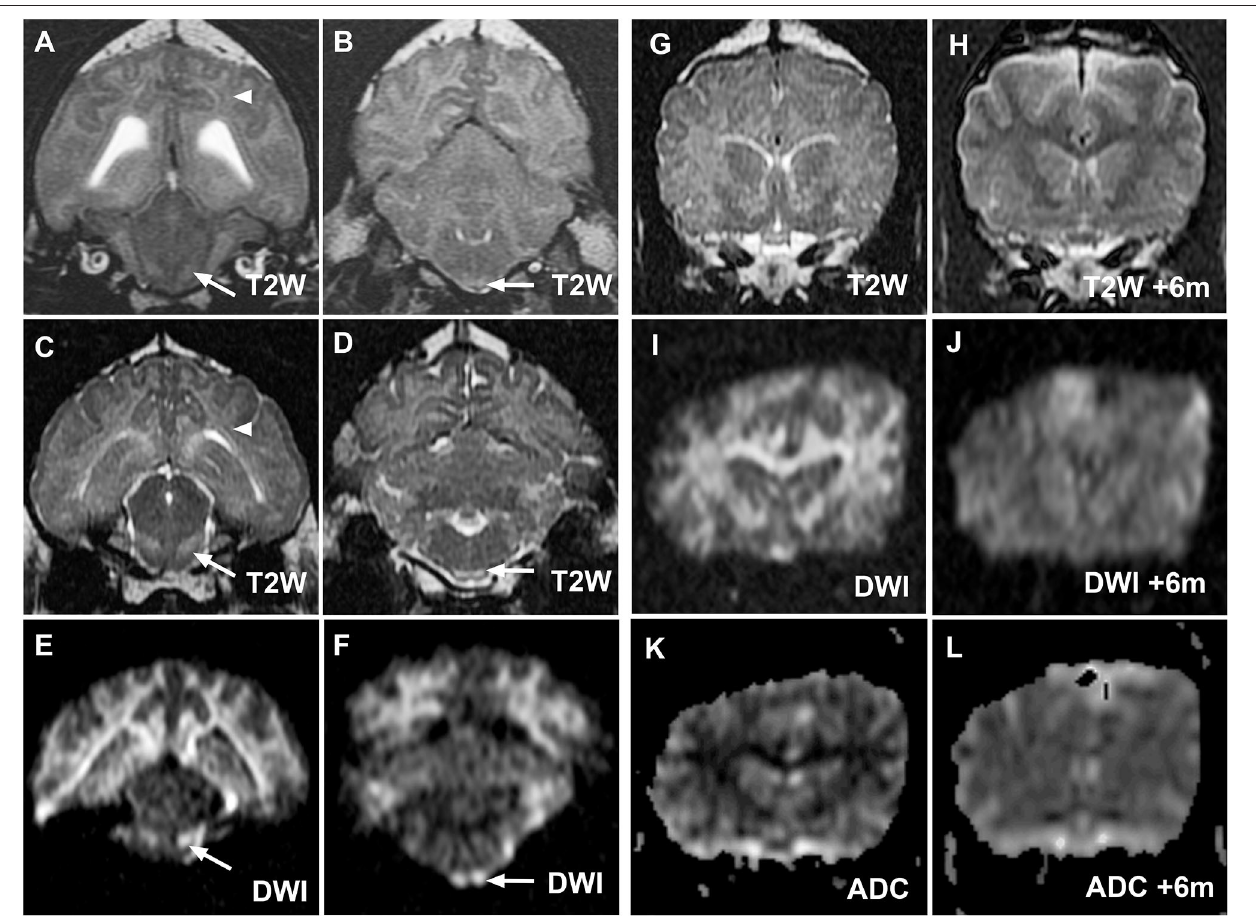
FIGURE 3 | MR images from cases 2 (A,B) and 3 (C–L) demonstrating similar hallmark corticospinal tract lesions in both cases and demonstrating resolution of MRI changes in case 3. Transverse T2W images at the level of the midbrain and medulla oblongata for cases 2 (A,B) and 3 (C,D) demonstrate hyperintensity of corona radiata (white arrowheads) and prominence of the corticospinal tracts (white arrows) within the brainstem as in case 1. Lesions are again most noticeable on diffusion-weighted imaging (DWI) images from case 3 [ (E,F) , white arrows]. Case 3 initial transverse T2W (G) , DWI (I) and apparent diffusion coefficient (ADC) map (K) images at the level of the caudate nuclei confirm restricted diffusion within white matter tracts as in case 1. Reversal of imaging abnormalities on repeated T2W (H) , DWI (J) , and ADC map (L) 6 months later was consistent with resolution of clinical